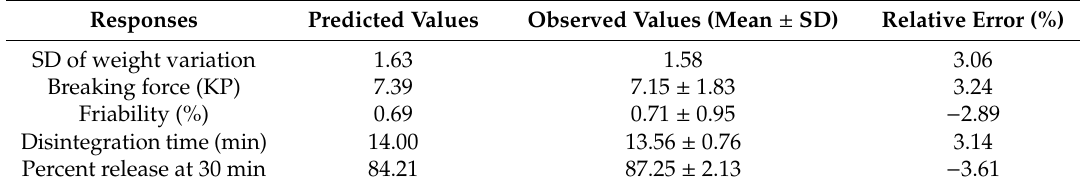
Figure 4. Contour plot showing the levels of optimized process variables and overall desirability. Table 7. Predicted and observed (actual) values for dependent responses of optimized run with their relative